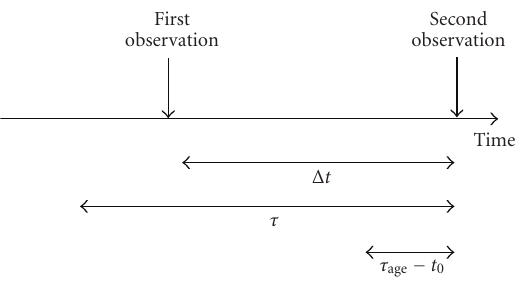
Figure 2: Example of how the detection probabilities are calculated. Δ t is the cadence; τ is the time period when the transient remains detectable and τ age − t 0 is the time period when the transient remains detectable while it is younger than τ age . In this case, the cadence is shorter than τ , which means that some transient events of the type of interest could have already been seen in the first observation, but τ age − t 0 is shorter than the cadence, which means that all events younger than τ age could not have been seen in the first observation. The minimum between these three quantities should be multiplied by the rate of events in order to compute the expected number of events and compute the detection